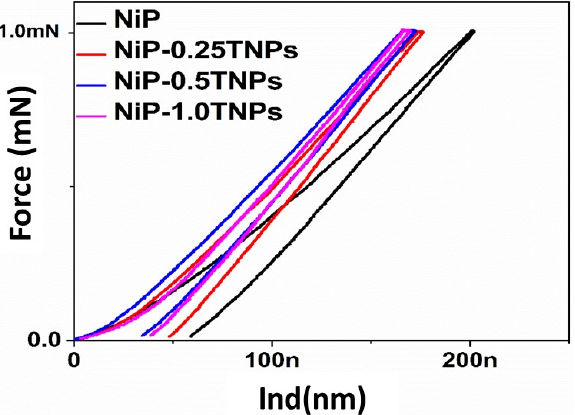
Figure 7. Nanoindentation loading-unloading curve for NiP, NiP-0.25TNPs, NiP-0.5TNPs and NiP- 1.0TNPs nanocomposite